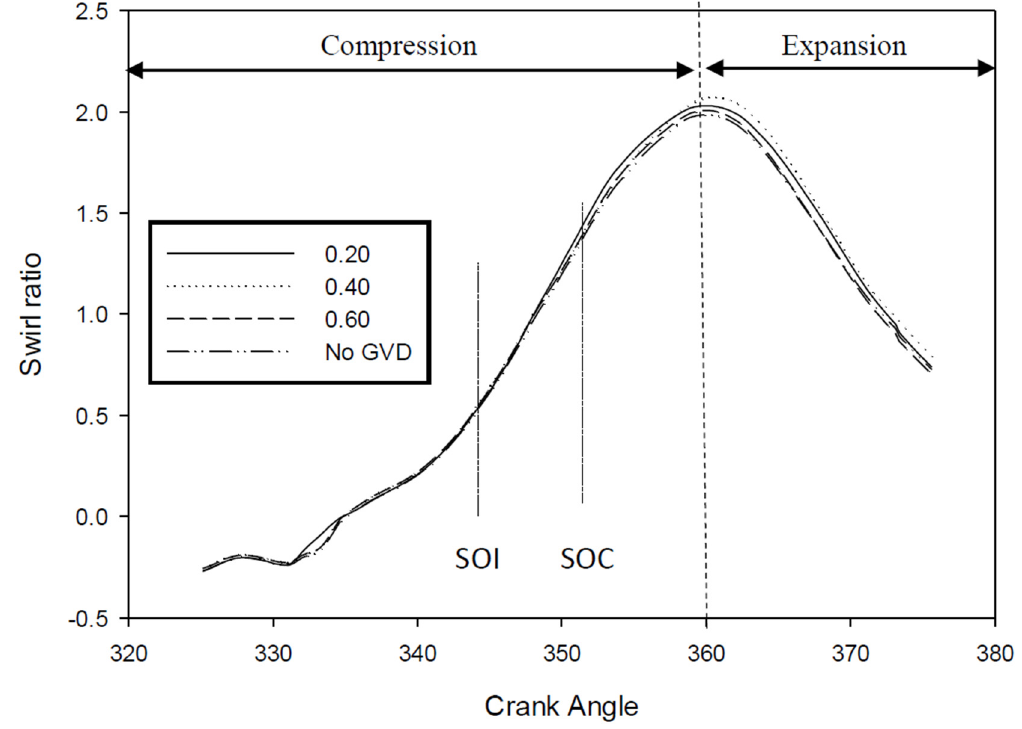
Figure 9. Swirl ratio (Rs ) against the crank angle ( θ ).